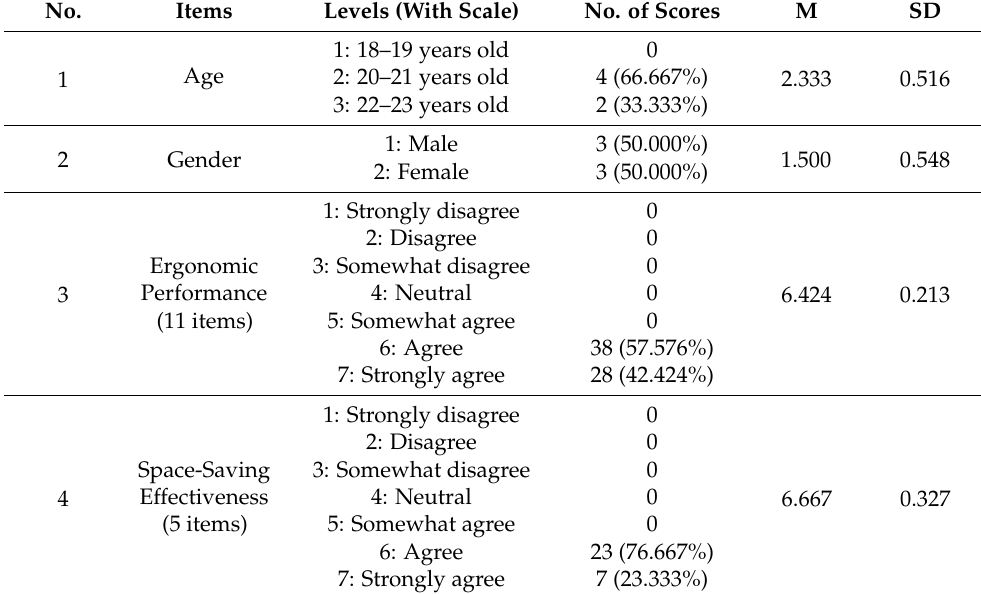
Table 18. Participant demographics by age and